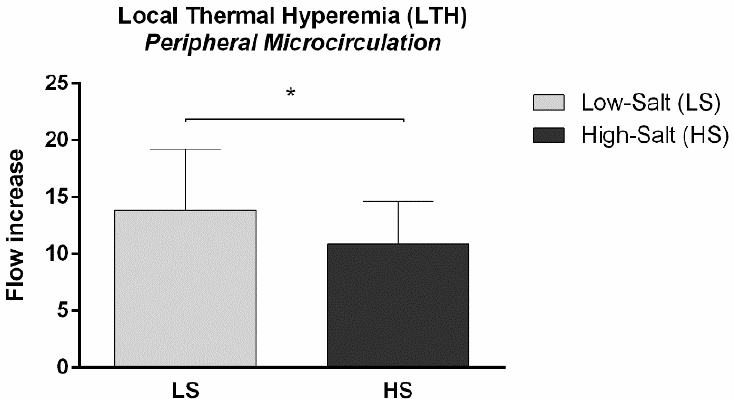
Figure 1. The effect of a 7-day high-salt (HS) diet on a microvascular nitric oxide (NO)-mediated vasodilation in healthy individuals. Local thermal hyperemia (LTH) of forearm skin microcircula- tion measured by laser Doppler flowmetry (LDF) significantly decreased following 7-day HS diet compared to LS diet condition in healthy individuals. * p = 0.009, LS vs. HS (Paired t